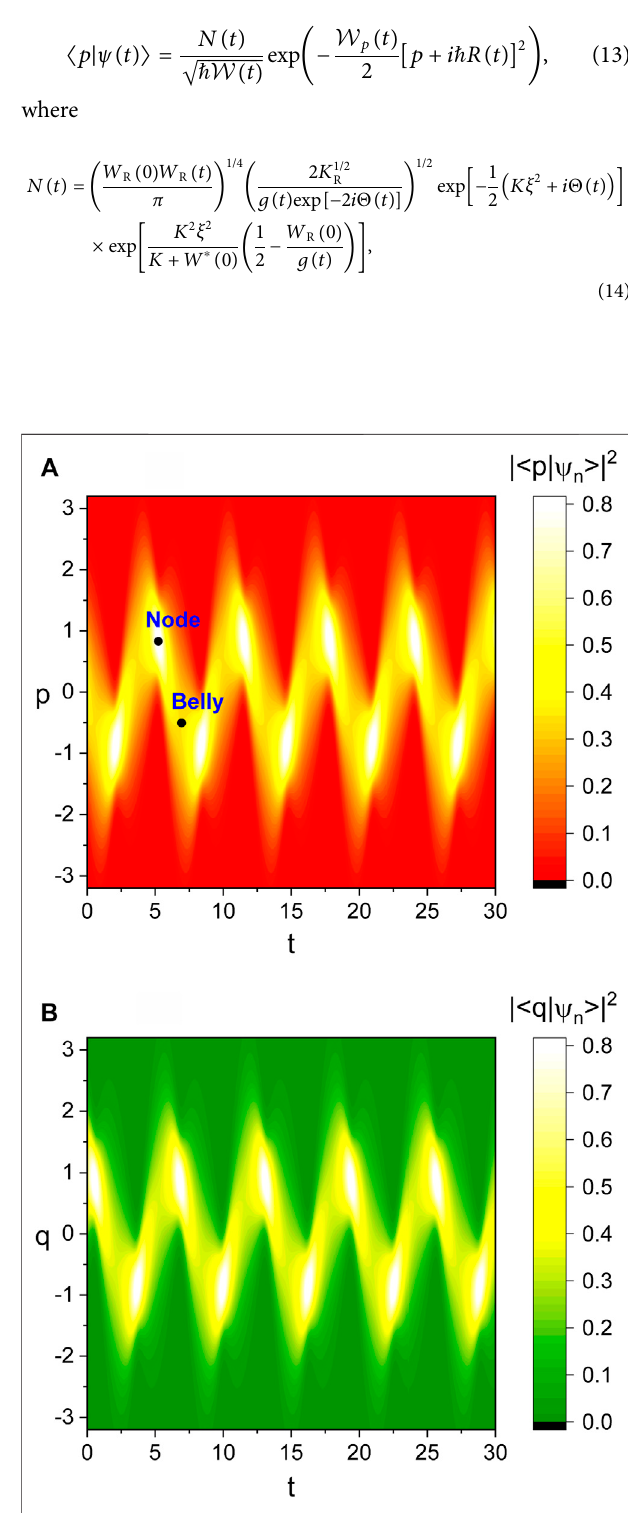
FIGURE 4 | This is the same as Figure 3 , but with the choice of ξ (cid:1) 1.